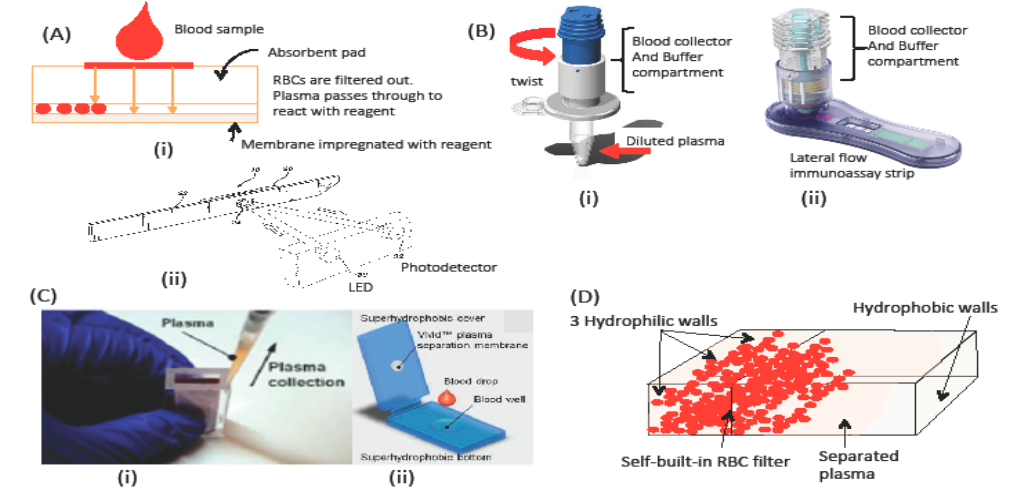
Figure 3. ( A ) Test strip from SureStep® technology. ( B ) FABPulous device designed for heart-type fatty acid binding protein for diagnosis of acute coronary problem. Courtesy of FABpulous, image adapted from www.FAbpoulos.com. ( C ) Plasma collector by Liu et al. group, from [49,50]. and ( D ) In-lab self-built Red Blood Cells (RBC) filter adapted from Reference [53].